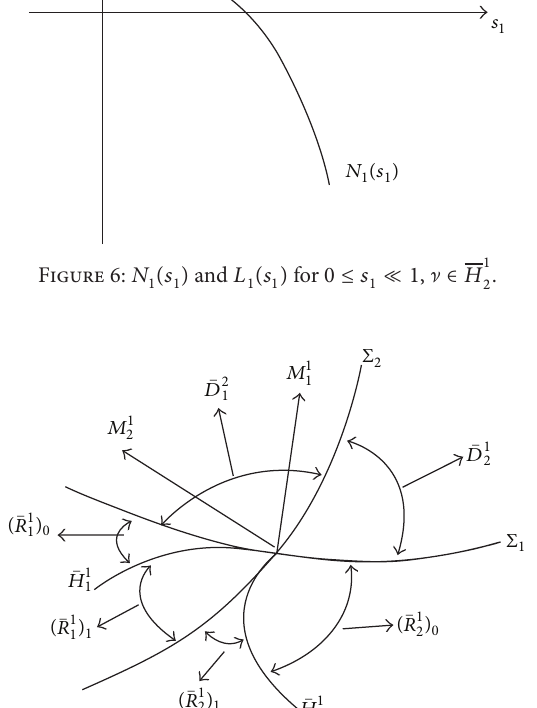
Figure 7: Bifurcation diagram in case Δ 1 = −1 , Δ 2 = 1 , 0 < 𝛼 ≪ 1 .